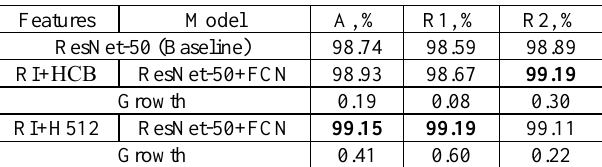
Table 3 . Comparative table of hybrid method’s efficiency: RI - raw image.